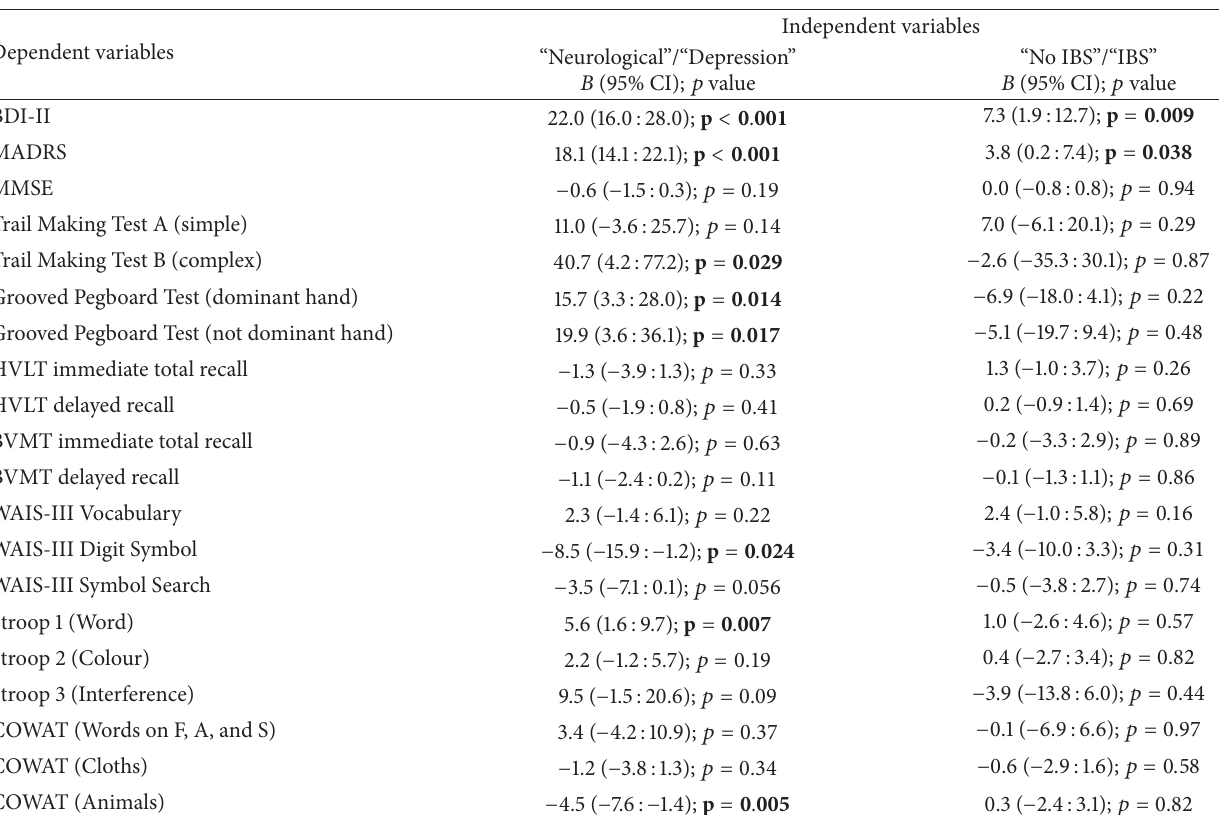
Table 4: The associations between depression and cognitive functions and the groups “Neurological”/“Depression” and “no IBS”/“IBS.” The results of linear regression analyses after adjusting for age, sex, and years of